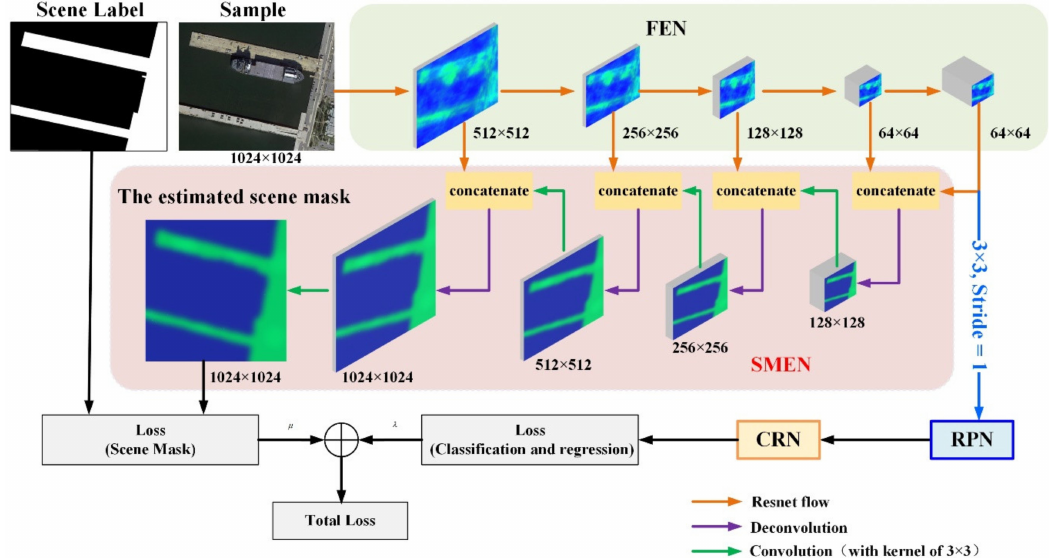
Figure 6. The framework of the Mask-Faster R-CNN for sea-land segmentation and ship detection, which include a feature extraction network (FEN), a scene mask extraction network (SMEN), a region proposal network and a classification and regression network (CRN), which is just for regression and classification of the region